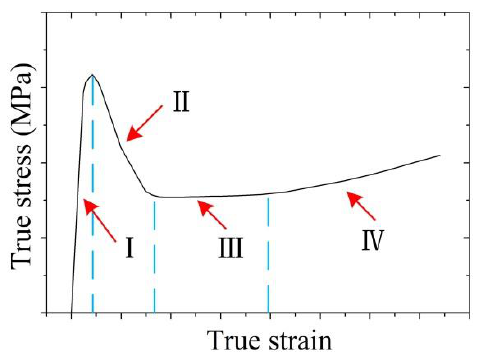
Figure 4. The deformation pattern of the cold radial forged 6063 aluminium alloy processed by